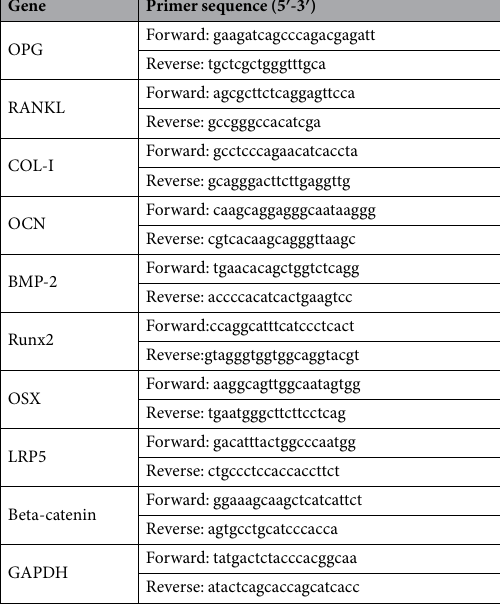
Table 1. Primers for qRT-PCR in vivo.